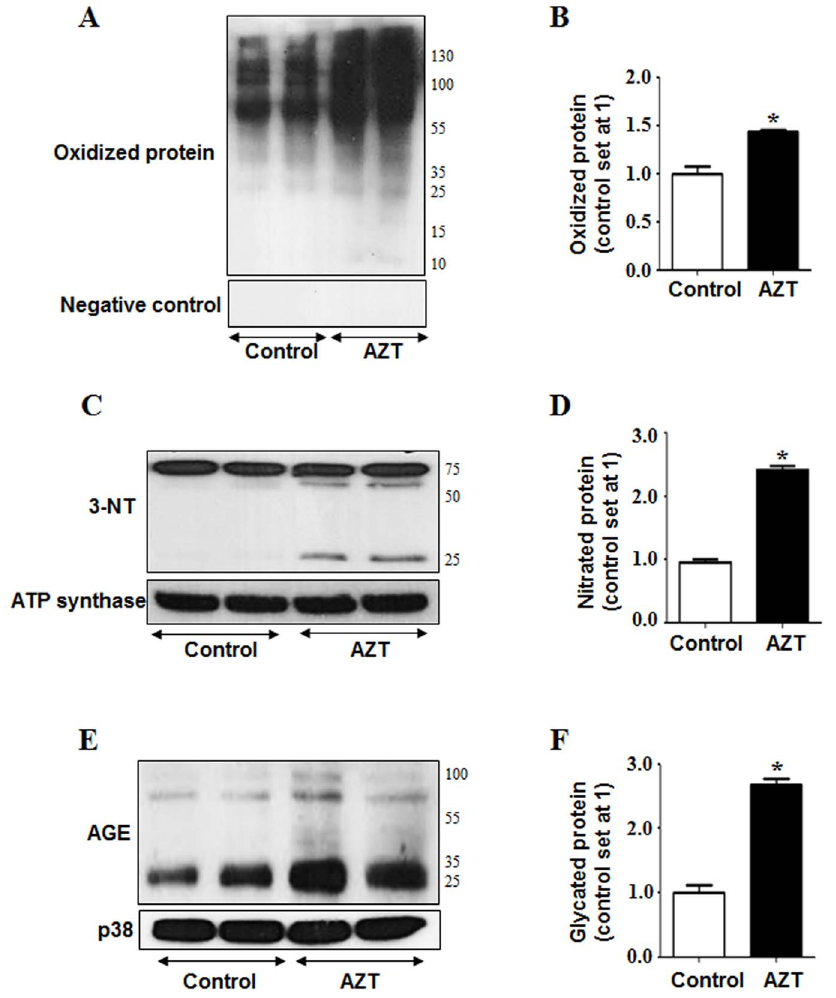
Figure 4. AZT-mediated protein modifications. (A) Equal amounts of mitochondrial proteins (50 m g/lane) from the different groups were used to evaluate protein oxidation (upper panel) using Oxyblot analysis or negative control (lower panel). (B) Densities of mitochondrial oxidized proteins were normalized with that of the controls set at 1. (C) Equal amounts of mitochondrial proteins were used to evaluate protein nitration as reflected by 3-NT bands (upper panel) and ATP synthase loading control (lower panel) from different groups. (D) The densities of mitochondrial 3-NT bands were normalized to that of ATP synthase and plotted as the value of controls being 1. (E) Total liver homogenates (50 m g/lane) were used to evaluate the levels of AGE (upper panel) and p38 (lower panel) as a loading control. (F) The densities of AGE bands were normalized to that of p38 and plotted as the value of controls being 1. *Significantly different from the control group. Data indicate mean 6 SE, p , 0.05. All experiments have been conducted three